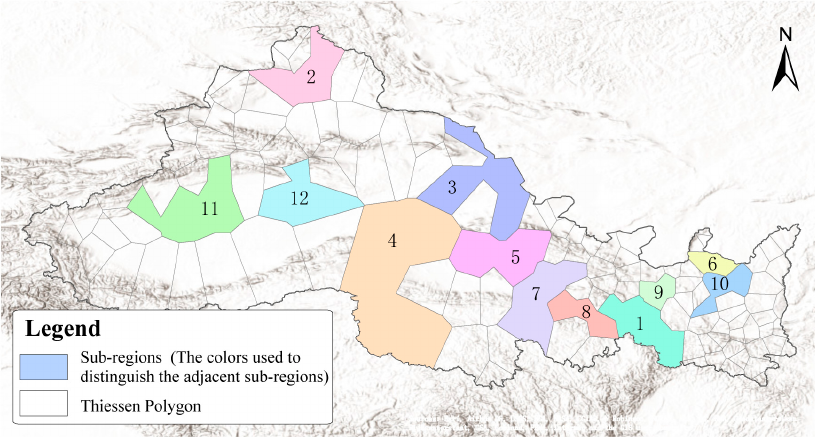
Figure 7. Result of sub-region division considering terrain differences and similarity of wind re- sources.